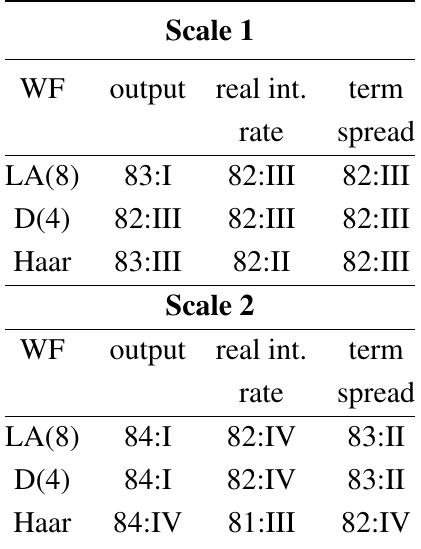
Table 4. Variance change location (phase